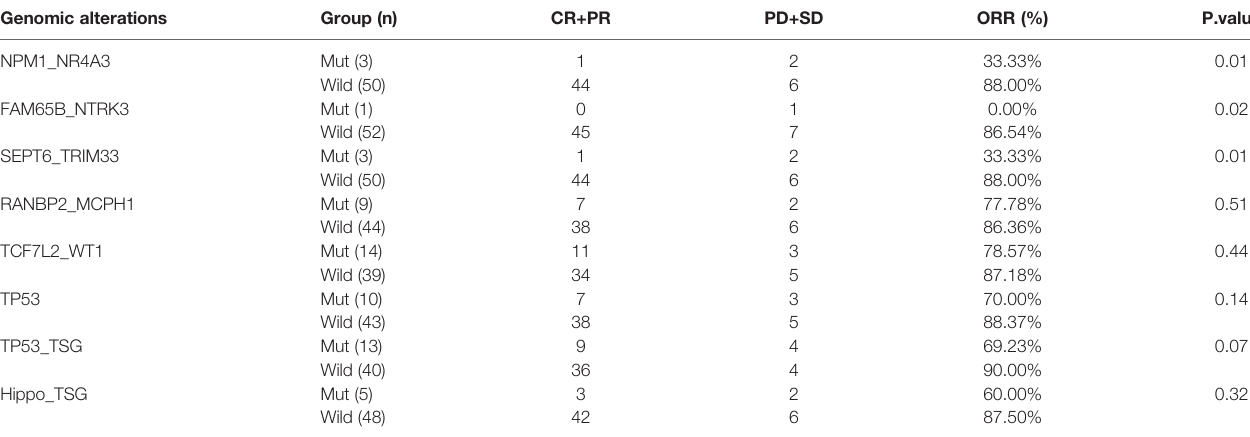
TABLE 3 | Relationship between genomic alterations and clinical response to treatment. Genomic